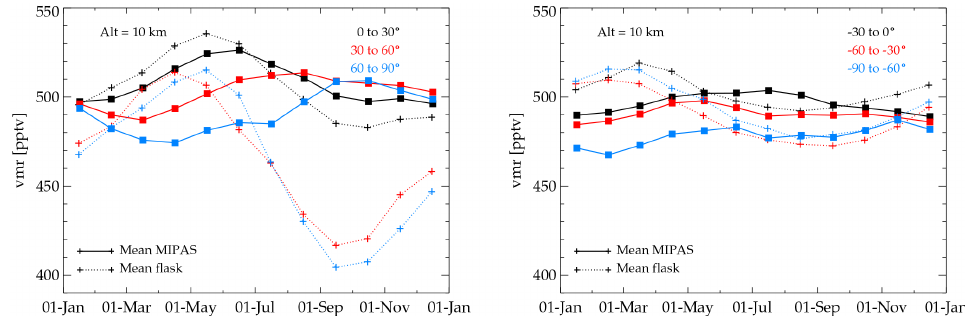
Figure 10. Monthly variation of OCS amounts measured by MIPAS during 2002–2012 (solid lines) and at surface stations (dotted lines) in the latitude bands 0–30 ◦ (black), 30–60 ◦ (red) and 60–90 ◦ (blue) in the Northern (left) and Southern Hemisphere (right). Surface data are averaged over all ESRL stations in the respective latitude bands and over the whole measurement period of